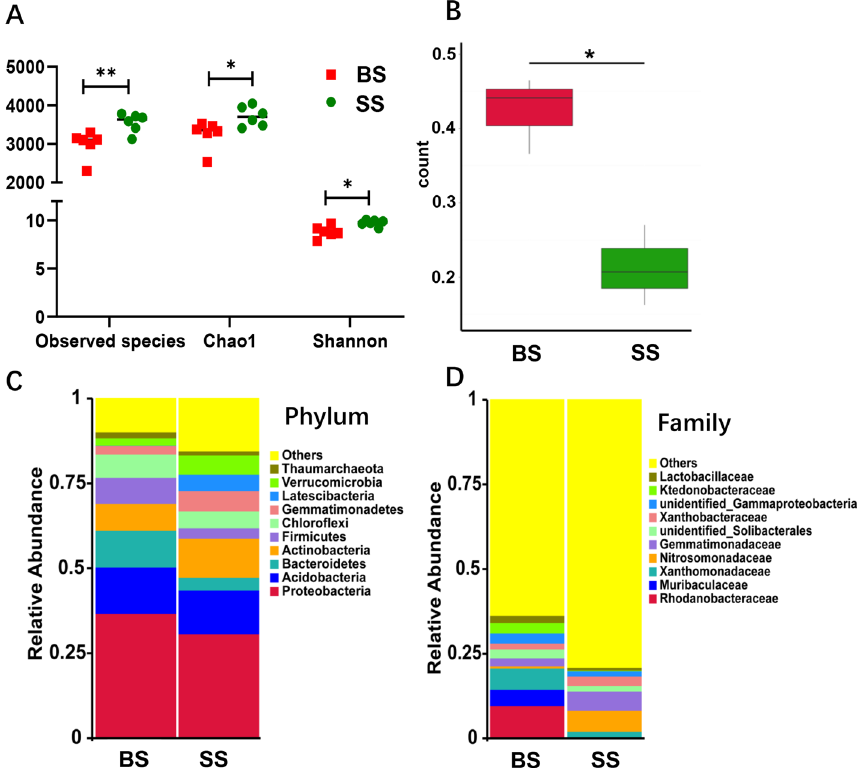
Figure 1. Soil microbiome diversity and structure analysis. BS , bitter sugarcane group, SS , sweet sugarcane group. ( A ) Alpha diversity differences between the BS and SS groups were estimated by the observed species, Chao1, and Shannon indices. ( B ) Beta diversity differences between the BS and SS groups. Taxonomic differences in microbial community for BS and SS at the phylum ( C ) and family ( D ) levels. ** P < 0.01, * P < 0.05. Figures were produced using R (v3.4.3, https ://www.R-proje